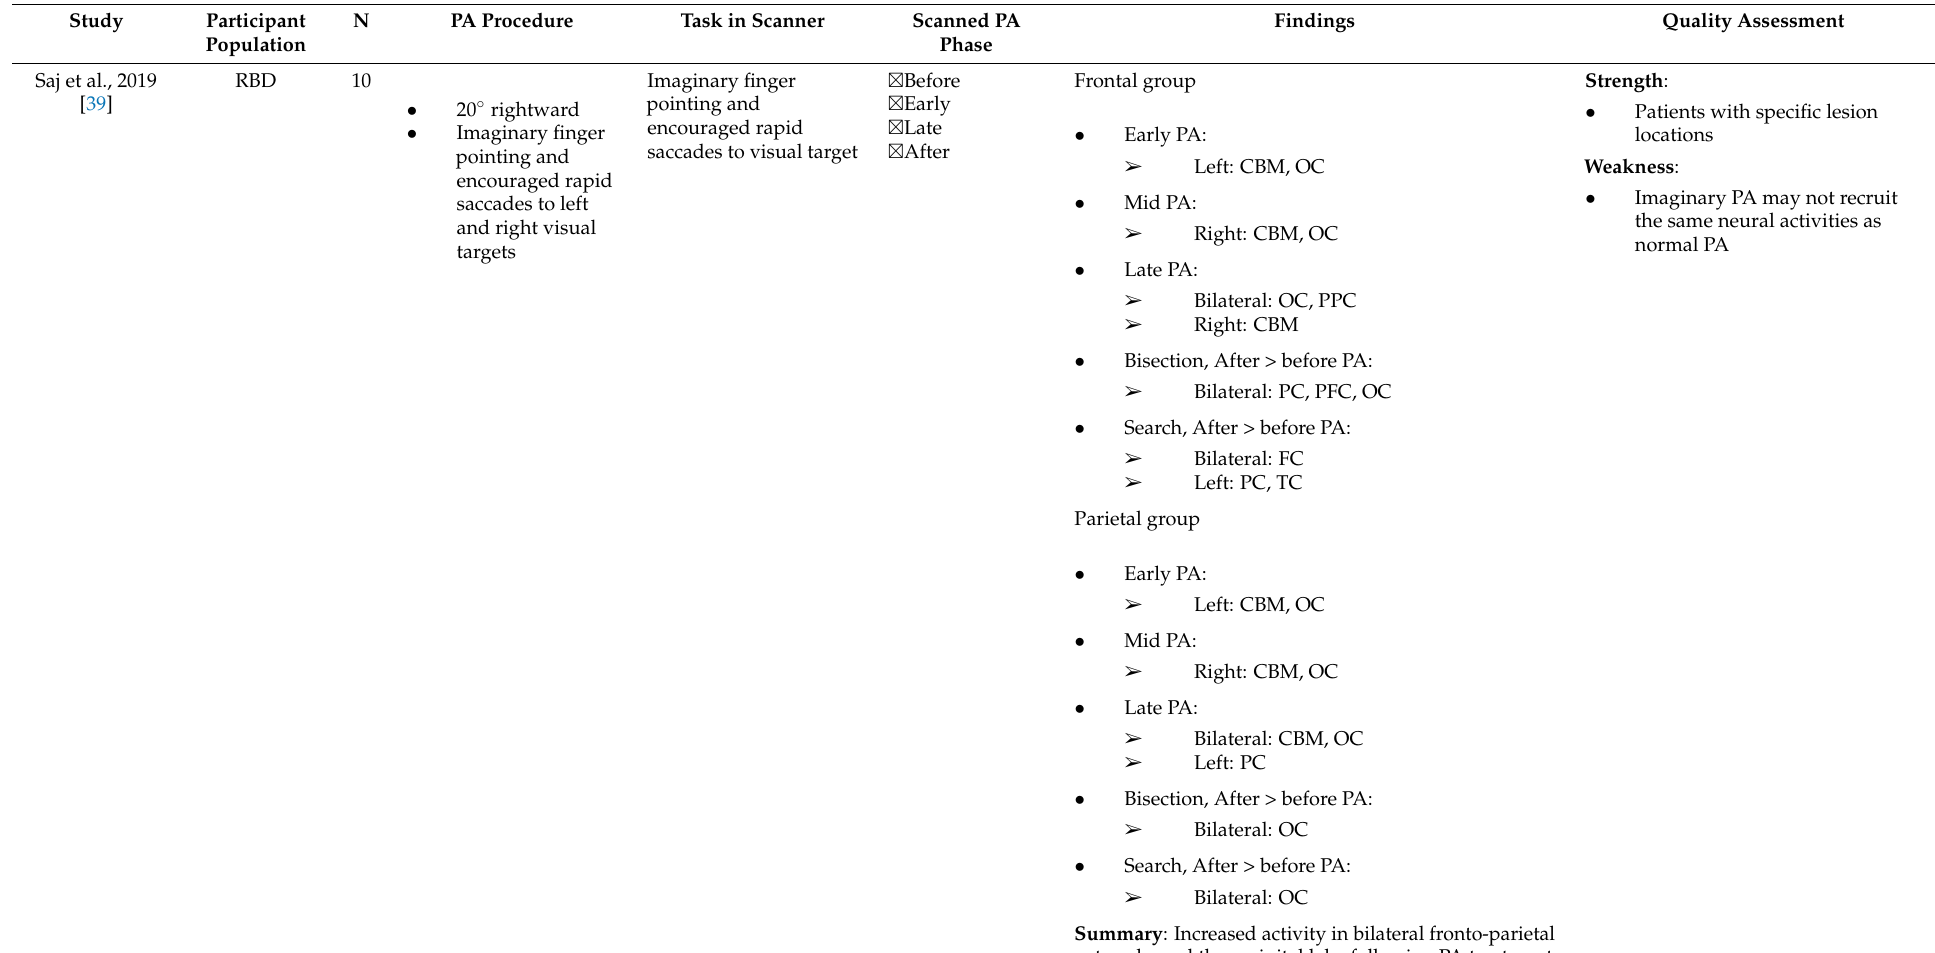
Table 1. Cont. Meta-Analysis 1: Before and after PA in Healthy